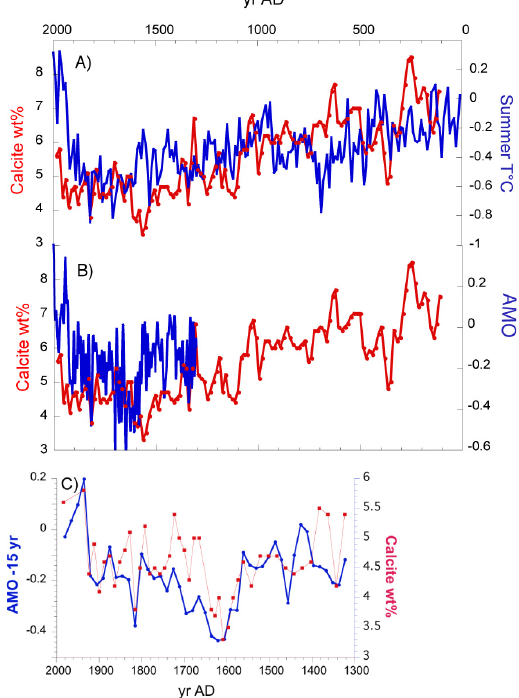
Fig. 10. (A) Plot of the calcite wt% from 19B/2322 (red) versus the summer temperature estimates (Kaufman et al., 2009) (blue). (B) Plot of the calcite wt% from 2322 (red) versus the AMO esti- mates for the last 700yr (blue) (Mann et al., 2009). (C) Plot of the AMO estimates (Man et al., 2009) (blue) and corrected calcite wt% chronology